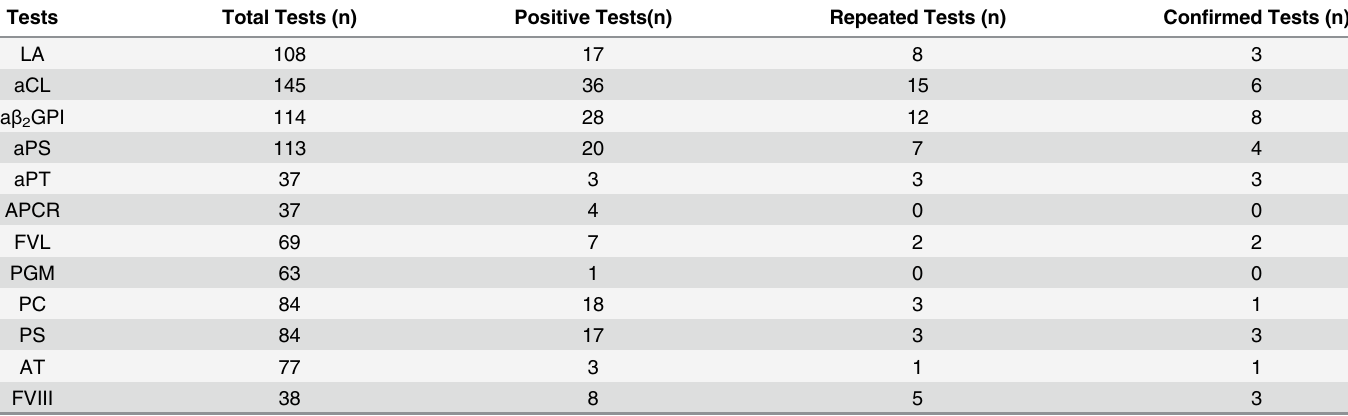
Table 2. Thrombophilia Tests Ordered and